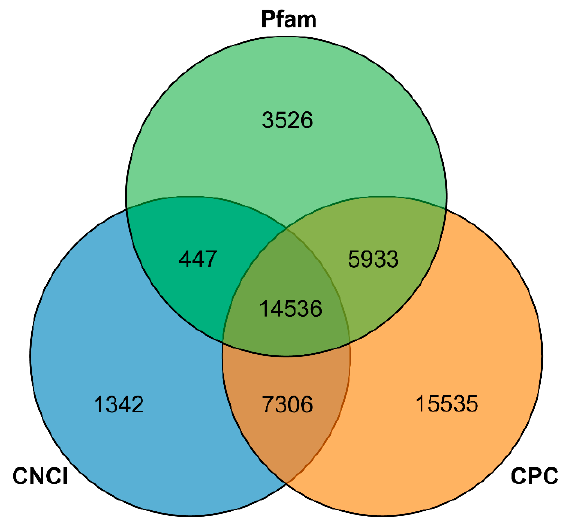
Figure 5. Coding ability prediction of Venn diagram. The blue circle, green circle, and yellow circle represent CNCI, CPC, Pfam, respectively.